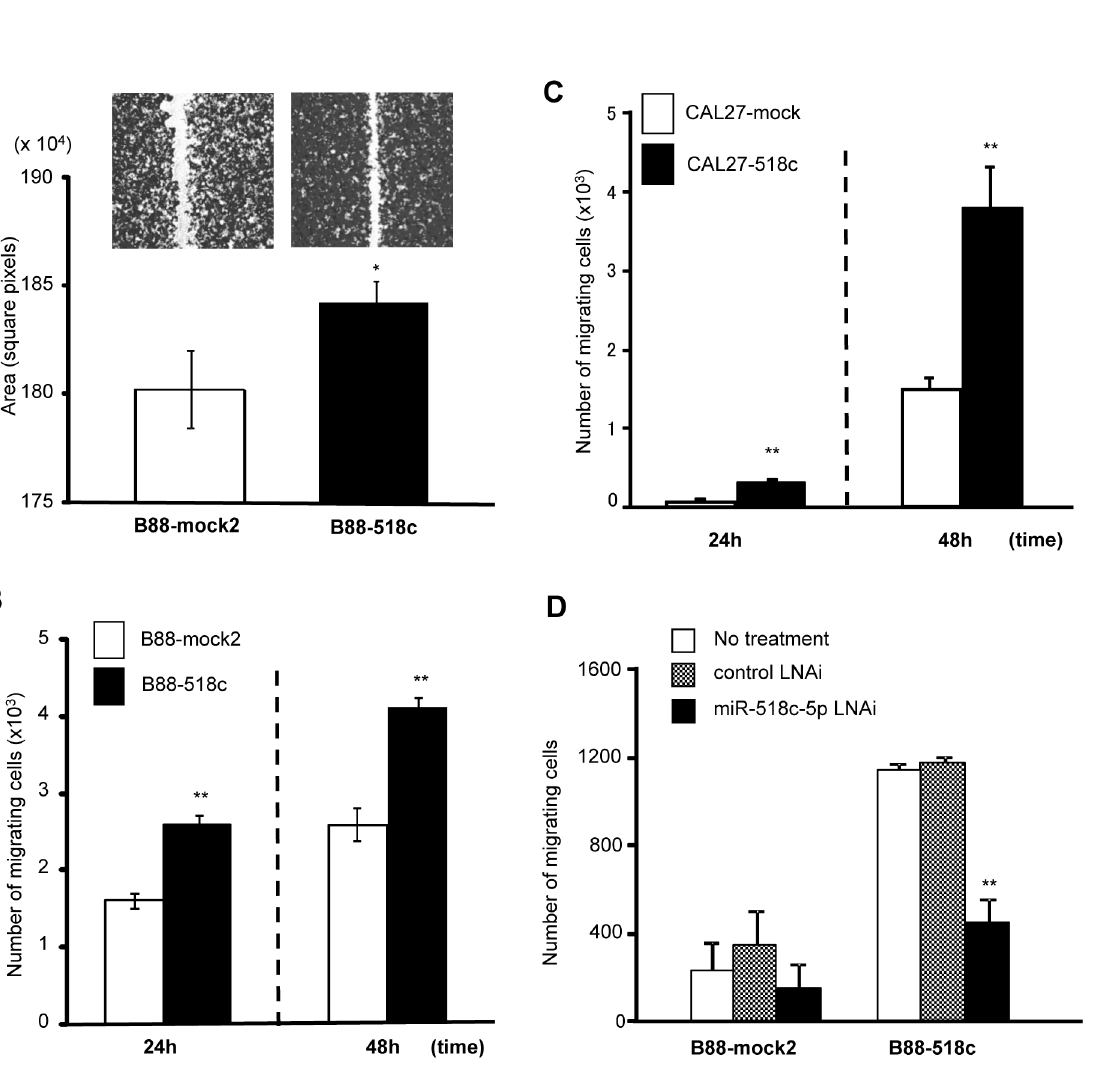
Fig. 4. miR-518c-5p overexpression also induced the migration of oral cancer cells. (A) B88-mock2 or B88-518c cells were cultured to confluence. A wound healing assay was performed. *; p , 0.05 when compared to mock cells by one-way ANOVA. (B,C) The motility of B88-518c cells (B) or CAL27-518c cells (C) was evaluated using a Transwell migration assay. Each transfectant was seeded at a density of 1 6 10 4 . **; p , 0.01 when compared to mock cells by one-way ANOVA. (D) The motility of B88-transfectants in the presence of either a control LNA inhibitor or a miR-518c-5p LNA inhibitor was also examined using a Transwell migration assay. **; p , 0.01 when compared to untreated control or control LNA inhibitor-treated cells by one-way ANOVA.